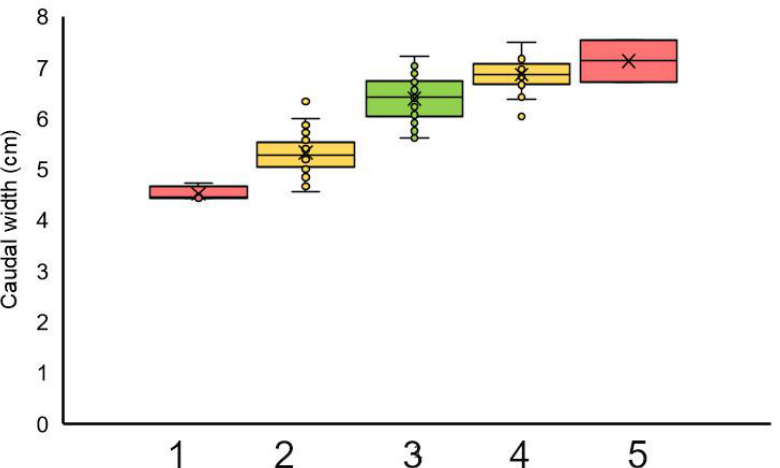
Figure 9. Caudal width (cm) scaled according to the groups calculated from body weight: length